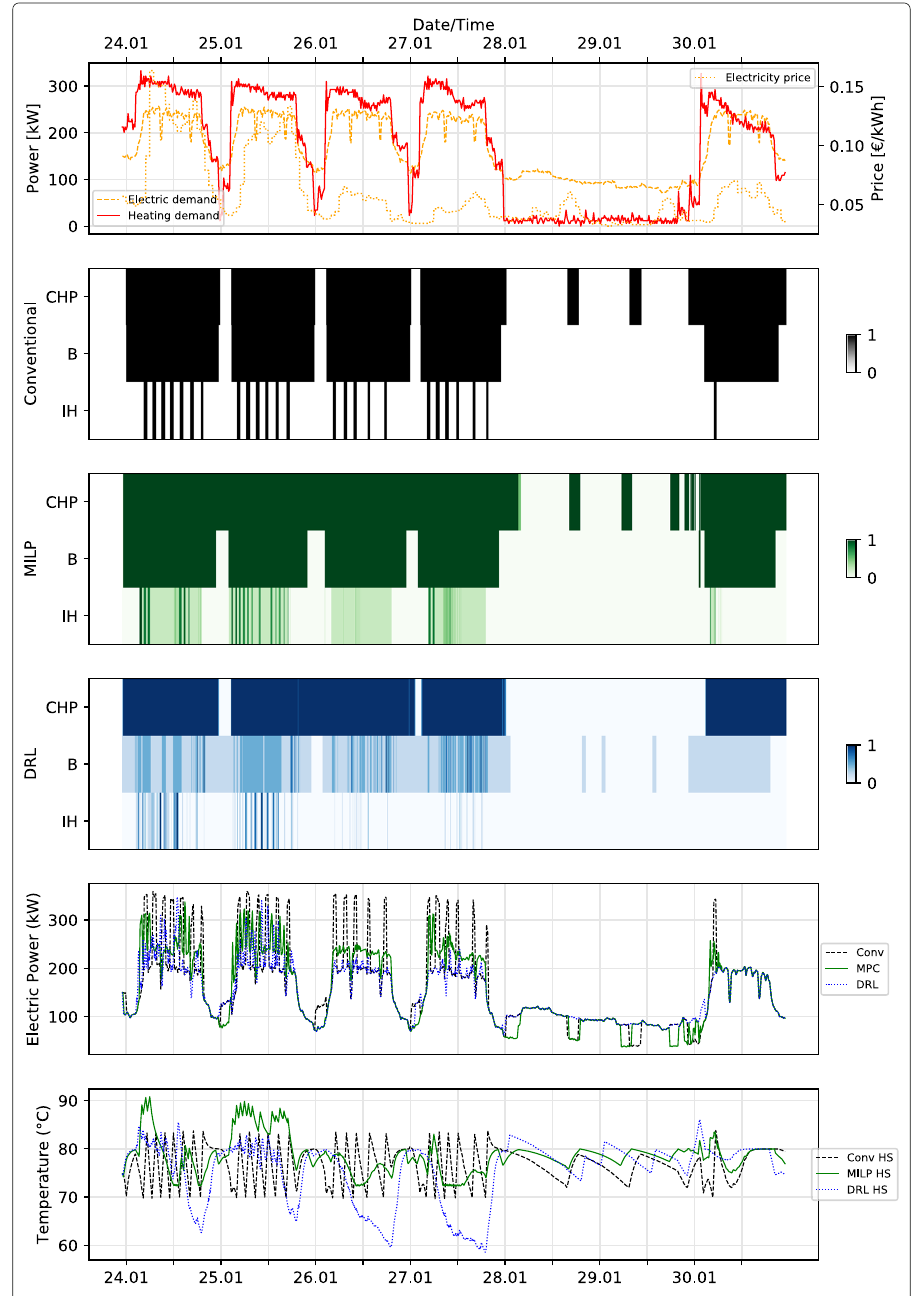
Fig. 5 Exemplary test run of system A with an episode duration of seven days and a sampling time of three minutes. Subplot 1 shows input parameters as electricity and heating demand of the production system as well es electricity prices. Subplots 2-4 show the resulting actions of the control algorithms and subplots 5 and 6 contain the electric power demand to the grid and the temperature of the